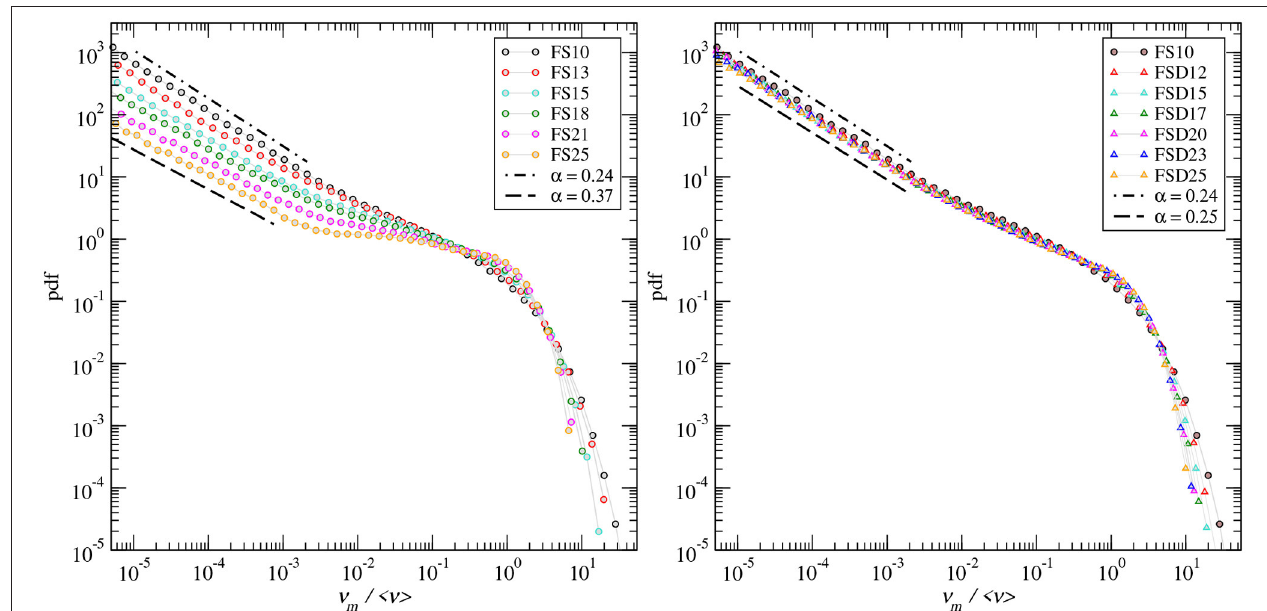
FIGURE 6 | Distribution of the Eulerian mean speeds p m ( v ) normalized to its mean, for the FS (left) and the FSD (right)